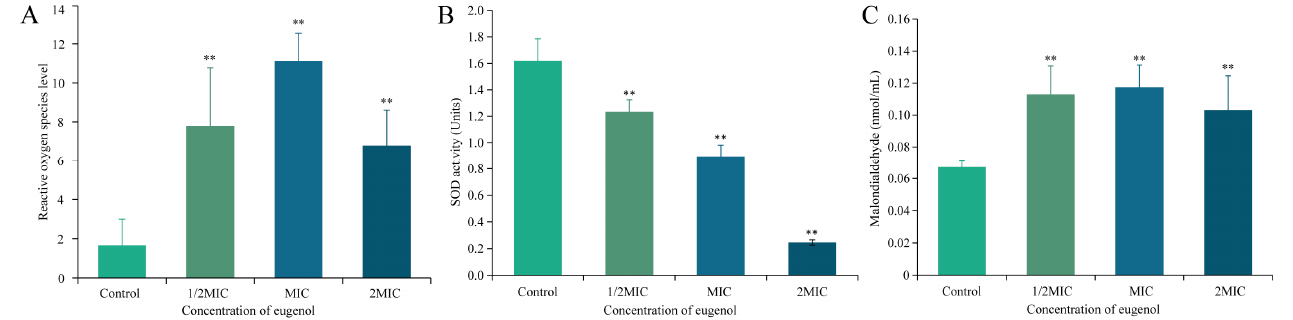
eugenol at 1/2MIC, MIC, and 2MIC, the intracellular ROS levels increased significantly ( p < 0.01) to 7.8 ± 3.0, 11.1 ± 1.4, and 6.8 ± 1.8, respectively.